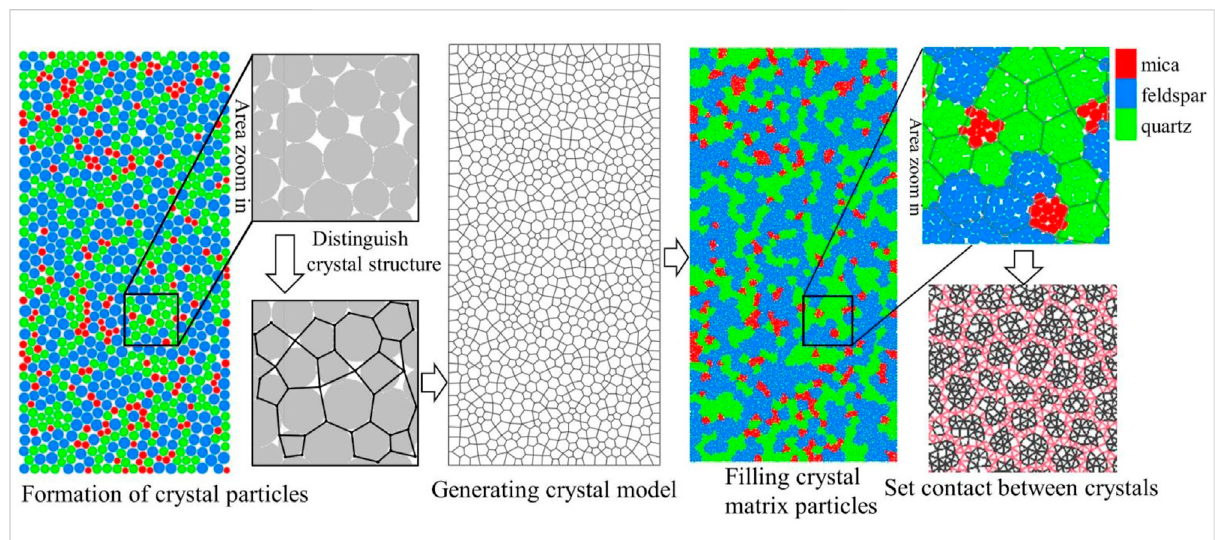
FIGURE 5 GBM model